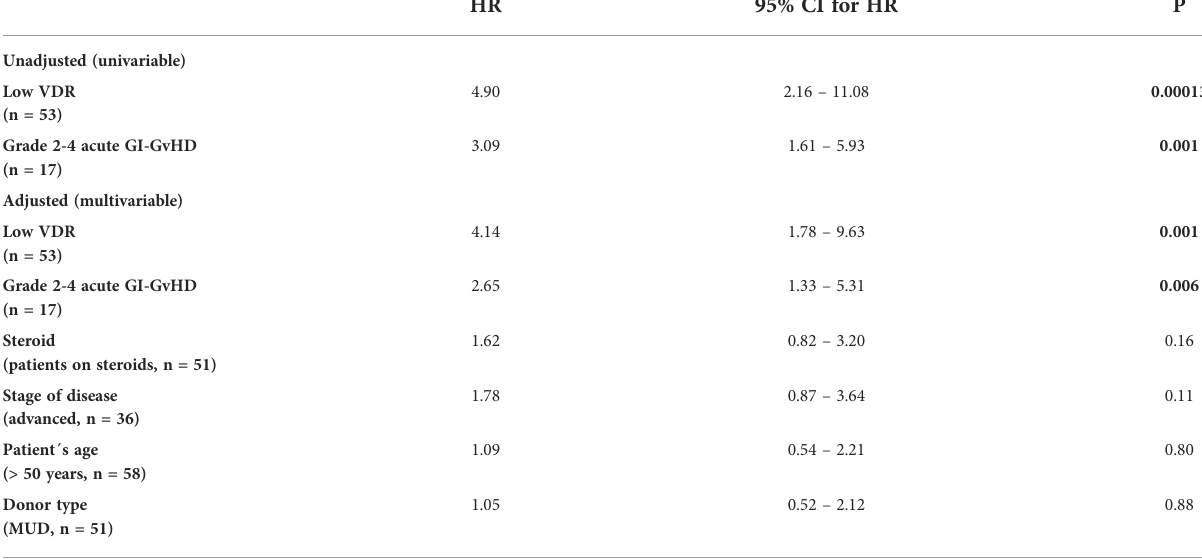
TABLE 2 Results from Cox regression analysis for